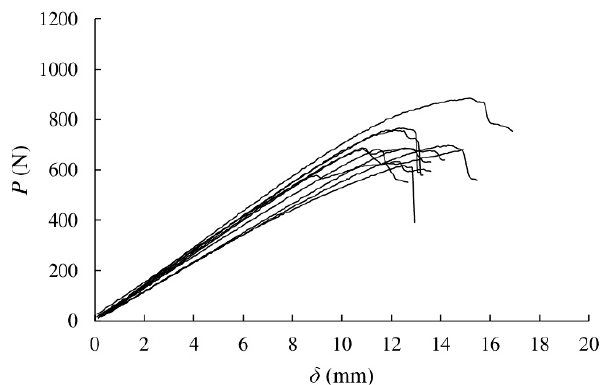
Figure 3. Load–displacement curves obtained from 10 eucalyptus specimens subjected to ENF tests.